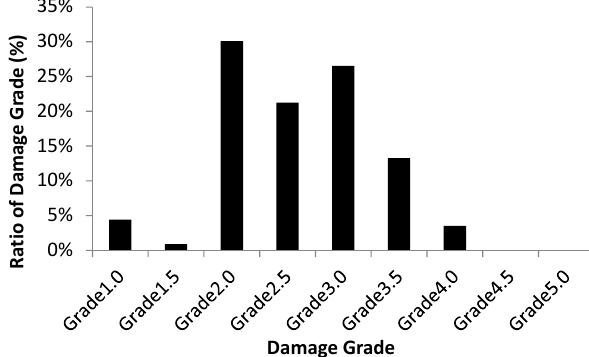
Figure 1. The ratios of the damaged buildings according to Modified EMS classification Fig. 1. The ratios of the damaged buildings according to modified EMS